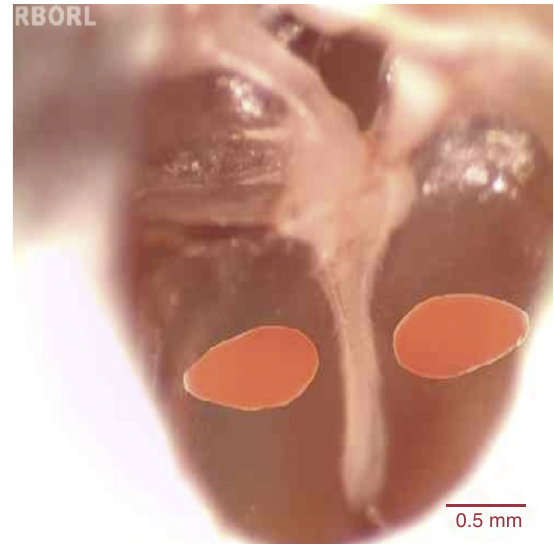
Schematic representation of tympanic perforation in the pars tensa region of the rat TM region, anteriorly and posteriorly to the malleus handle. handle as a reference. To allow histological evaluation, the blocks were worn until they reached approximately the same perpendicular level relative to the malleus handle. Samples